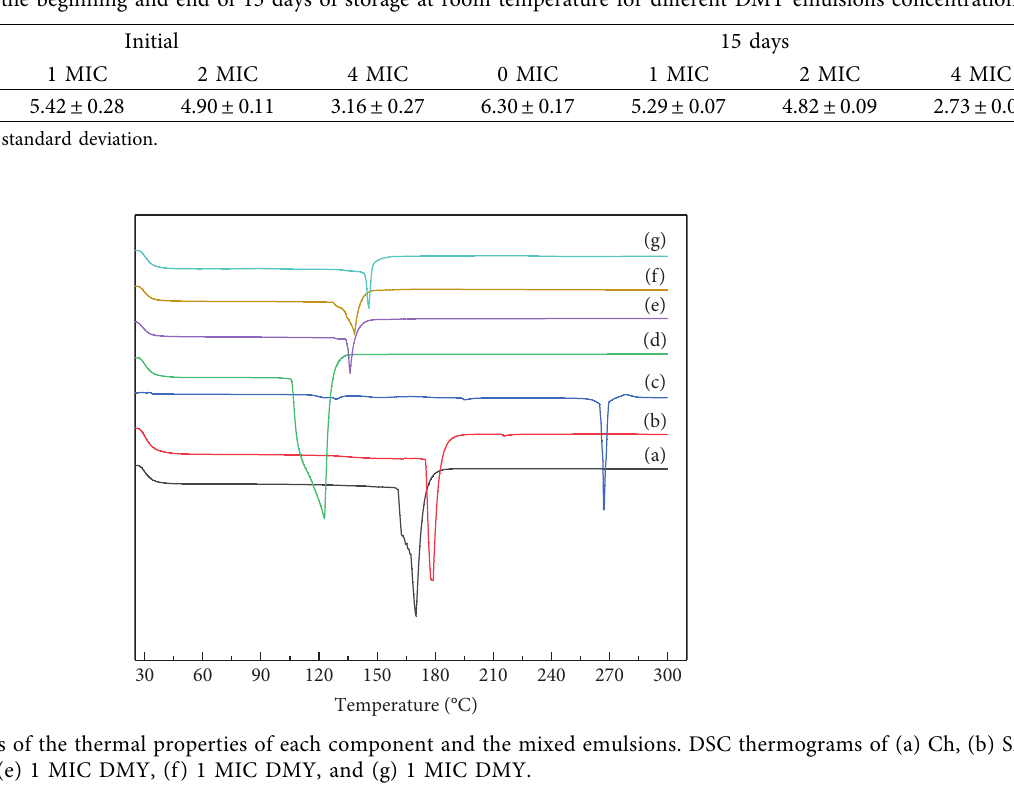
Table 3: pH values at the beginning and end of 15 days of storage at room temperature for different DMY emulsions concentrations.